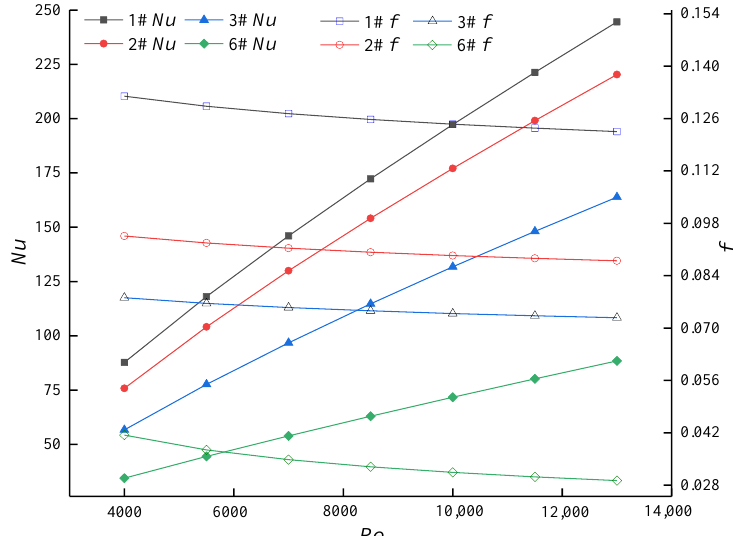
Figure 7. Effect of thread pitch on f and Nu .